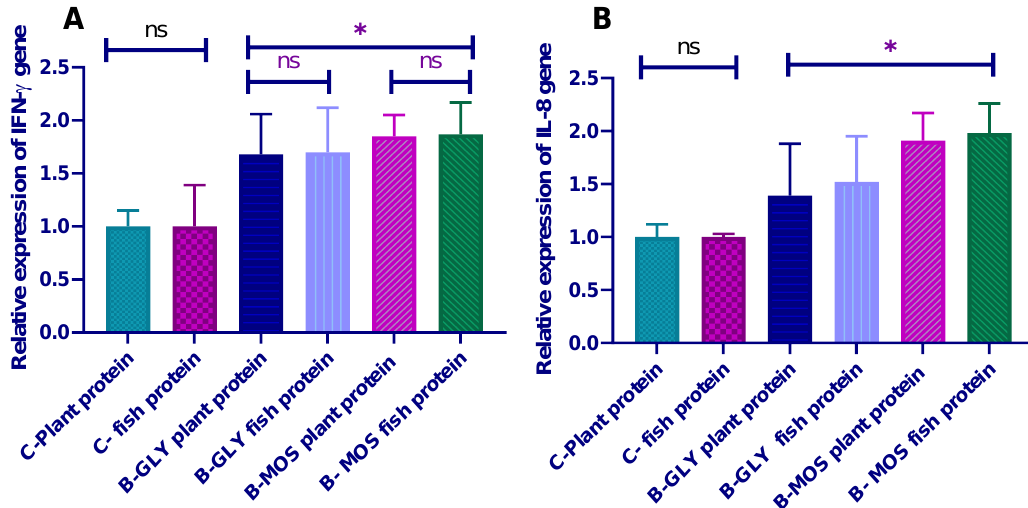
Figure 2. E ff ect of dietary protein source and carbon source on proinflammatory cytokine ( A ) IFN- γ : interferon gamma and ( B ) IL-8: interleukin-8) expression profile in Nile tilapia prechallenge (data are expressed as mean ± SEM). * Bars with an asterisk correspond to values that are significantly different (Tukey, p < 0.05); ns Bars with (ns) correspond to values that are not significantly different.